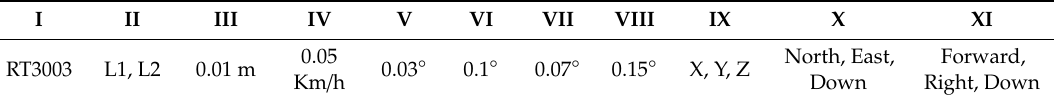
Table 1. GPS characteristics. The column numbers represent the following: I. Standard, II.